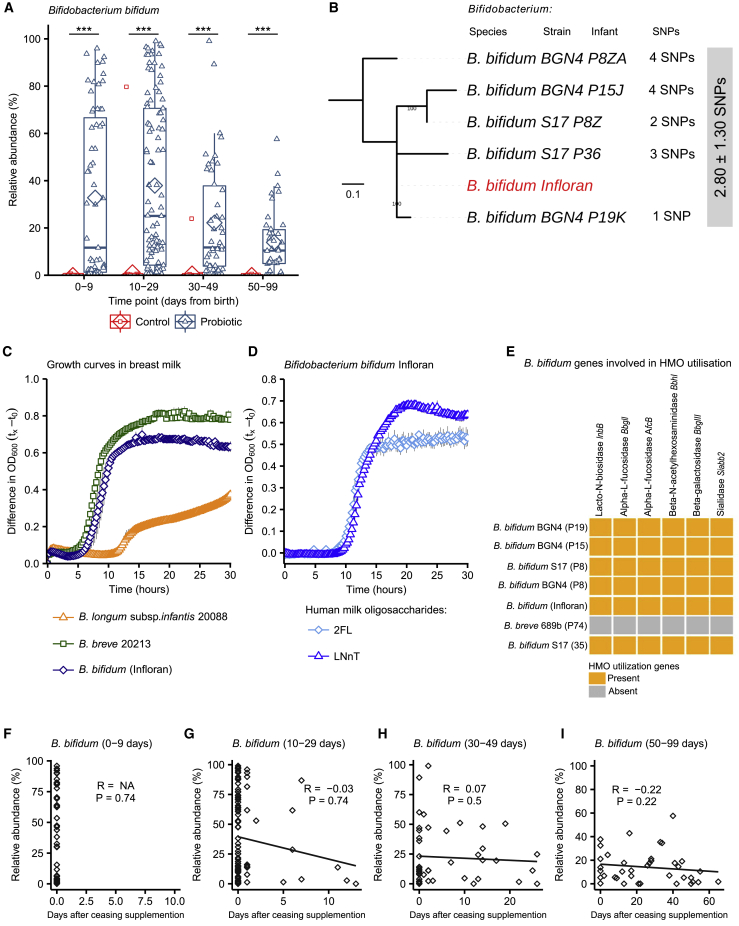
Comparison of B. bifidum Genomes and Phenotypic Characterization of B. bifidum Infloran Strain(A) B. bifidum abundance in Bif/Lacto and control group infants (0–9 days (control: n = 62, Bif/Lacto: n = 63); 10–29 days (control: n = 70, Bif/Lacto: n = 97); 30–49 days (control: n = 38, Bif/Lacto: n = 46); 50–99 days (control: n = 22, Bif/Lacto: n = 39)).(B) Mid-point rooted maximum-likelihood tree based on 12 SNPs called via reference-based approach (strain Infloran as the reference genome) from 5 B. bifidum genomes. The gray box denotes pairwise SNP distance between these 6 genomes. Data: mean ± SD.(C) Growth curves of B. bifidum Infloran, B. breve 20213, and B. longum subsp. infantis 20088, in whole human milk.(D) Growth curves B. bifidum Infloran in human milk oligosaccharides (HMO) Lacto-N-tetraose and 2-fucosyllactose.(E) Heatmap representing B. bifidum genes involved in utilization of human milk oligosaccharides.(F–I) Correlation between B. bifidum abundance and days after ceasing receiving supplementation (0–9 days: n = 63; 10–29 days: n = 97; 30–49 days: n = 46; 50–99 days: n = 39).Boxplots show group median and interquartile range, diamonds indicate the group mean, and individual points highlight individual infant samples. Asterisks represent p values: ∗∗∗p < 0.001. See also Figures S4 and S5 and Tables S2 and S5.